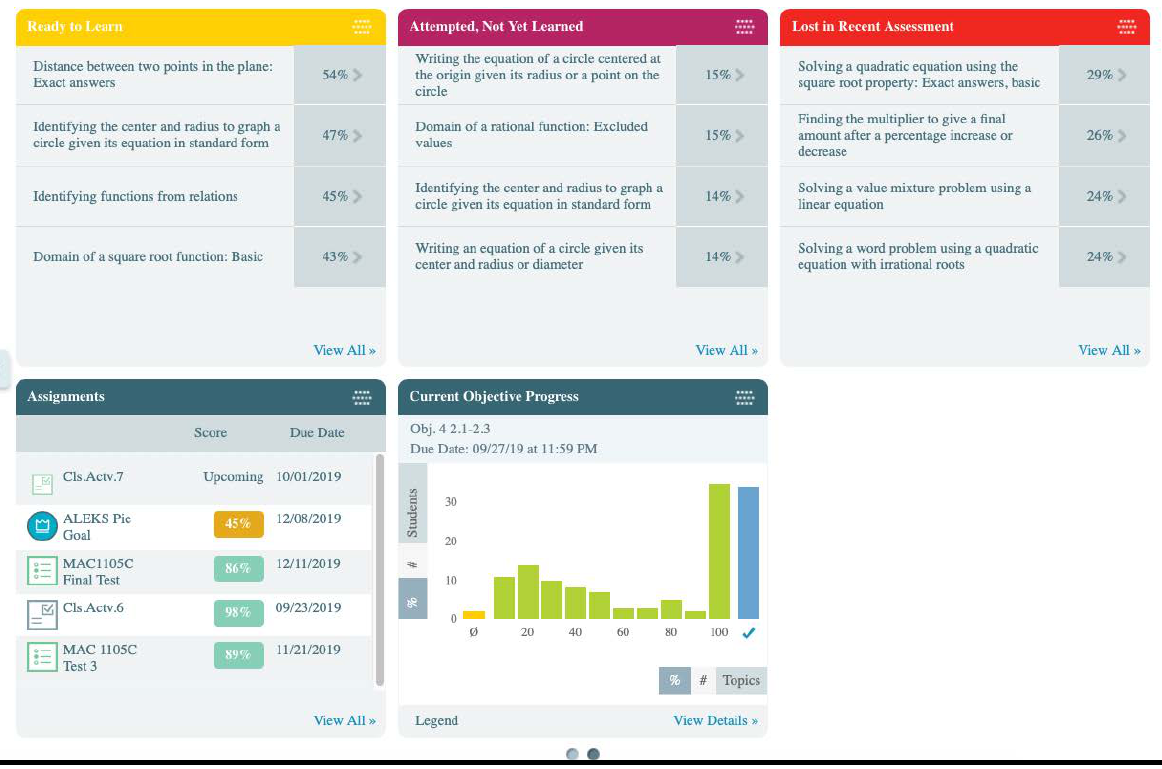
Figure 9a. Tiles on dashboard (ALEKS) offer analytics at the course section level. Each one can be expanded for details on the group of students that lost topics on a most recent assessment, attempted a topic but didn’t learn, or weren’t ready to learn certain topics. Adapted from MAC1105C: College Algebra , by R. Ait Maalem Lahcen, 2019, Orlando, FL: University of Central Florida. Copyright 2019 by the University of Central